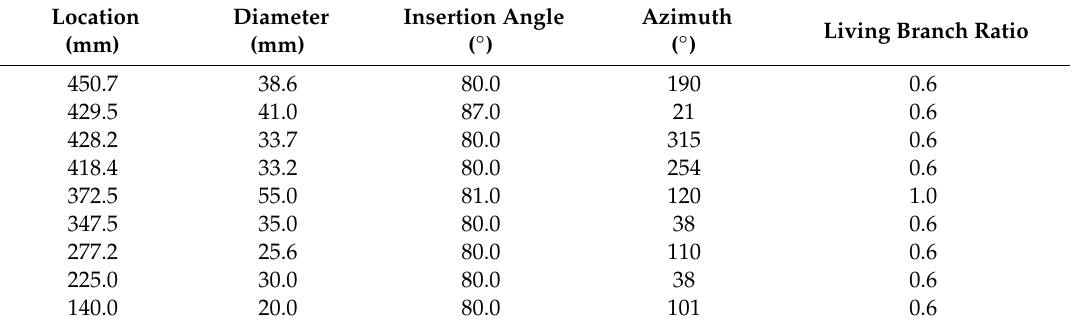
Figure 2. Picture of the local online orientation fiber analyzer (LOOBAR) laser scanner. Table 2. Measured information of the first log branches.